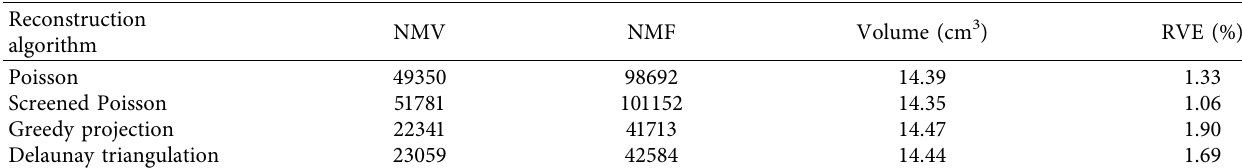
Table 2: Comparison of reconstruction models of different reconstruction